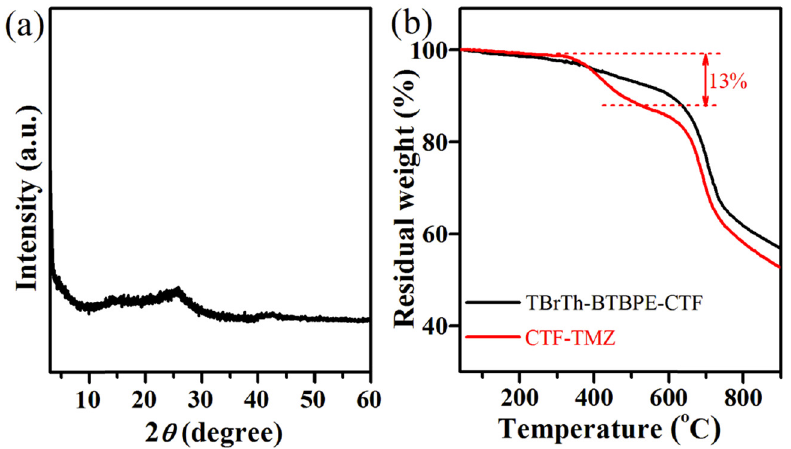
Figure 3: ( a ) PXRD pattern of TBrTh – BTBPE – CTF. ( b ) TGA pro fi les of TBrTh – BTBPE – CTF and CTF – TMZ measured under a nitrogen atmosphere.